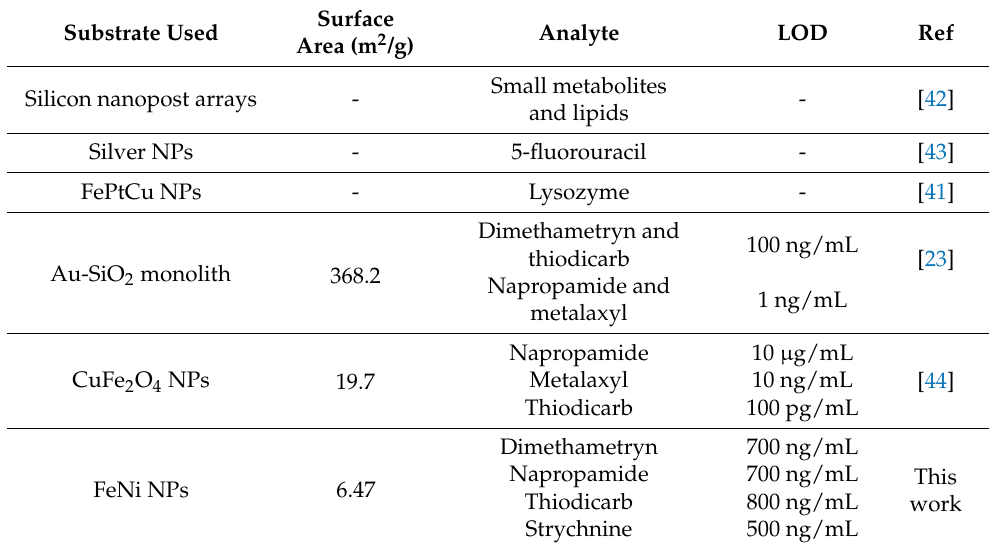
Table 4. Comparison of the findings of previous investigations and our study by substrate used, analyte, and LOD. Surface Analyte LOD Ref Substrate Used Area (m 2 /g) Small metabolites - [42] Silicon nanopost arrays - and lipids Silver NPs - 5-fluorouracil - [43] FePtCu NPs - Lysozyme - [41] Dimethametryn and 100 ng/mL thiodicarb Au-SiO 2 monolith 368.2 Napropamide